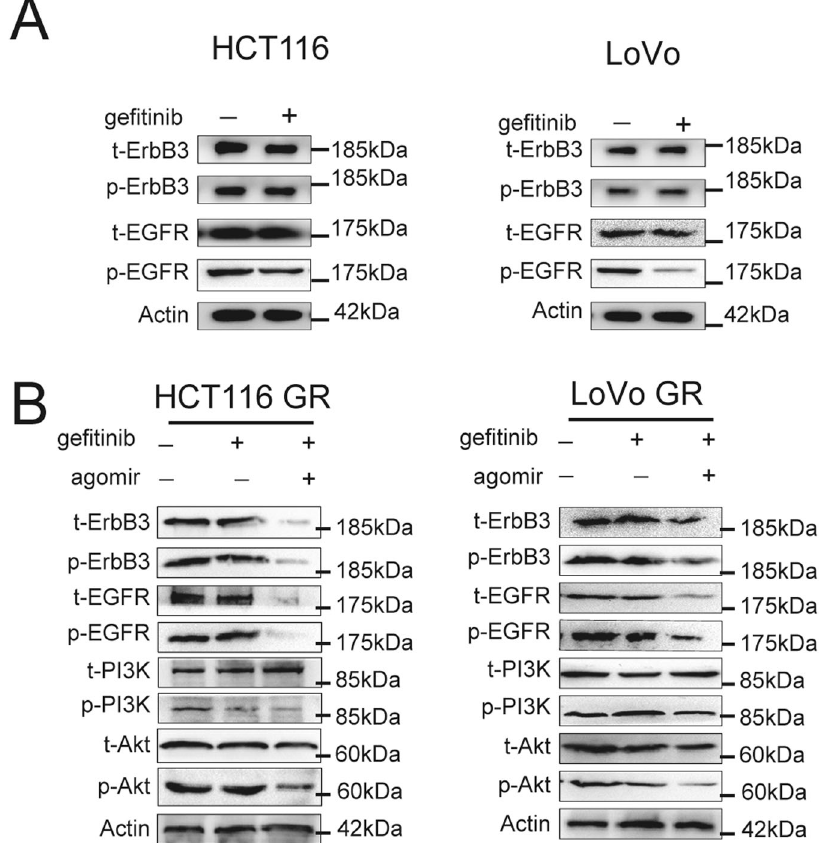
Fig. 5 MiR-323a-3p reverse ErbB3/EGFR activation in ge fi tinib-resistant CRC cell lines. A Ge fi tinib inhibited total and phosphorylated levels of ErbB3/EGFR in HCT116 and LoVo cells. B Ge fi tinib and miR-323a-3p inhibited total and phosphorylated levels of ErbB3/EGFR in ge fi tinib- resistant HCT-116 and LoVo cells, while Ge fi tinib did not inhibit alone. Ge fi tinib and miR-323a-3p inhibited phosphorylated levels of PI3K/AKT (downstream of ErbB3)